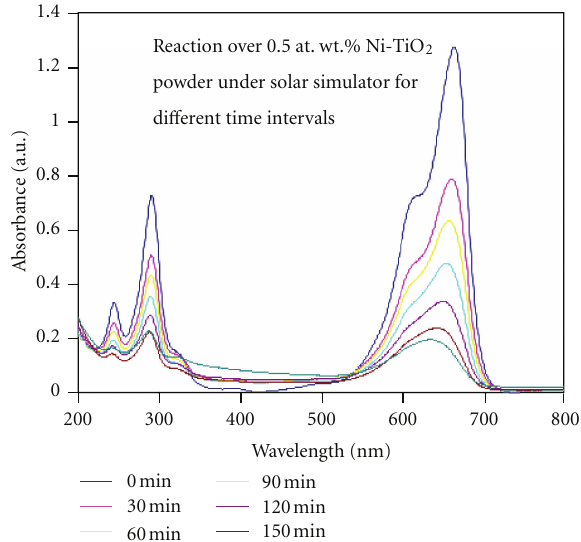
Figure 12: Photocatalytic degradation of methylene blue (MB) from 0.02 mM concentrated aqueous solution over 0.5 at. wt.% Ni- doped TiO 2 powder formed at 550 ◦ C for 6h under simulated solar light having a power density of about 44 mW/cm 2 for di ff erent time